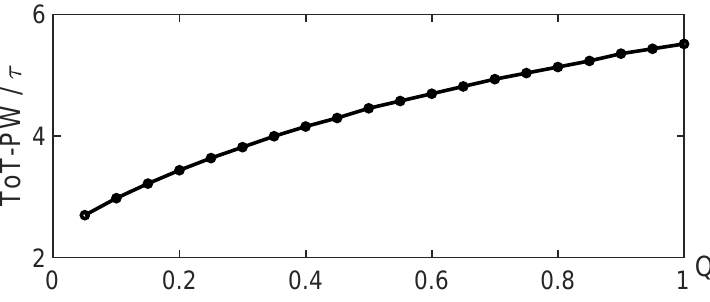
Figure 3. ToT-PW versus Q in for a given τ and V TH = 0.8 × V p . After the EM phase, i.e., the ToT-PW signal generation, the analog-channel time evolution decreases, returning to zero to prepare for the next event processing. In